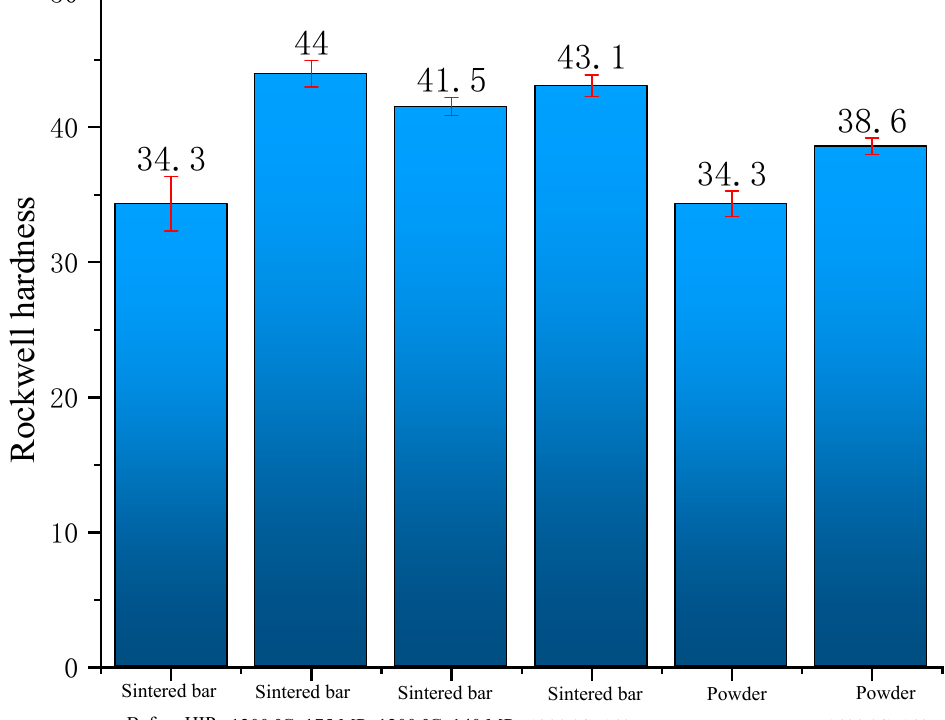
Figure 6. Rockwell hardness comparison before and after HIP.